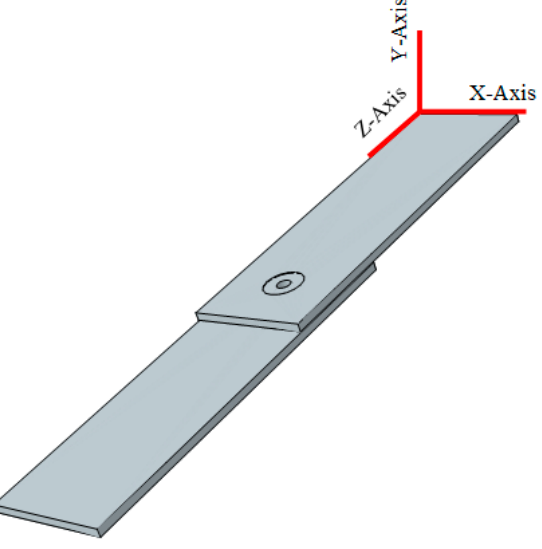
Figure 3. FEM of FSSW joints for structures with a probe hole.